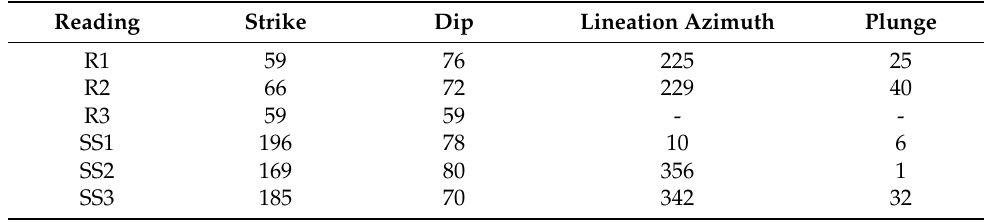
Figure 3. Examples of foliation in the study area. ( A ) Moderately SE-dipping foliation of Nasina Schists, which belong to the Upper Devonian to Mississippian Finlayson Group (DMF3) along the Bedrock Creek. ( B ) Steeply NE-dipping foliation of lighter-colored schists that belong to the Upper Devonian to Mississippian Finlayson Group (DMF1) in the Sixtymile River area. Refer to Figure 2 for location. ( C ) Plane polarized light thin section view of a sample from the Middle to Late Permian Klondike Schist (PK2), a strongly foliated, fine- to coarse-grained muscovite quartz schist (Sample DDH-11-15-3, 224.90 m–233.33 m; see supplementary Figures S1, S3 and S12E for sample location maps and a hand specimen image). Alternating layers of mica and quartz crystals with an evident preferred orientation can be observed. ( D ) Cross-polarized light view. Qtz—quartz, Mu—muscovite. Table 1. Fault structural